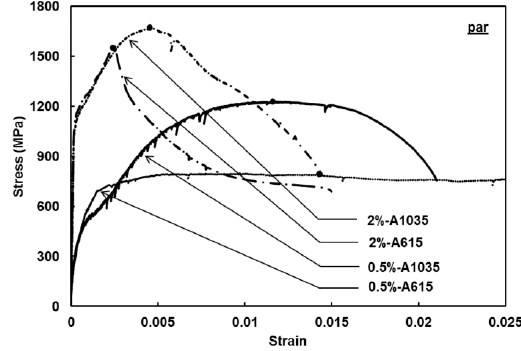
Figure 19. Effect of rebar type on stress versus strain response.